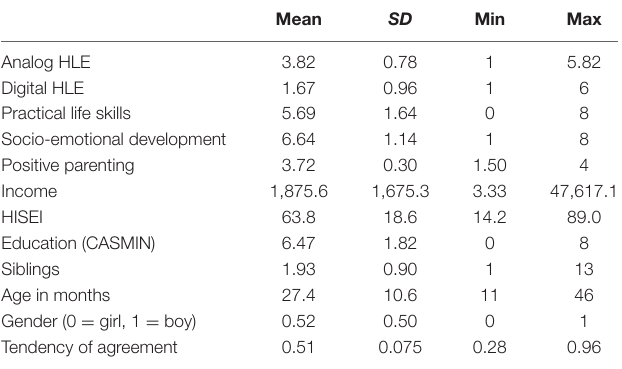
TABLE 1 | Descriptive statistics for the toddler age group.